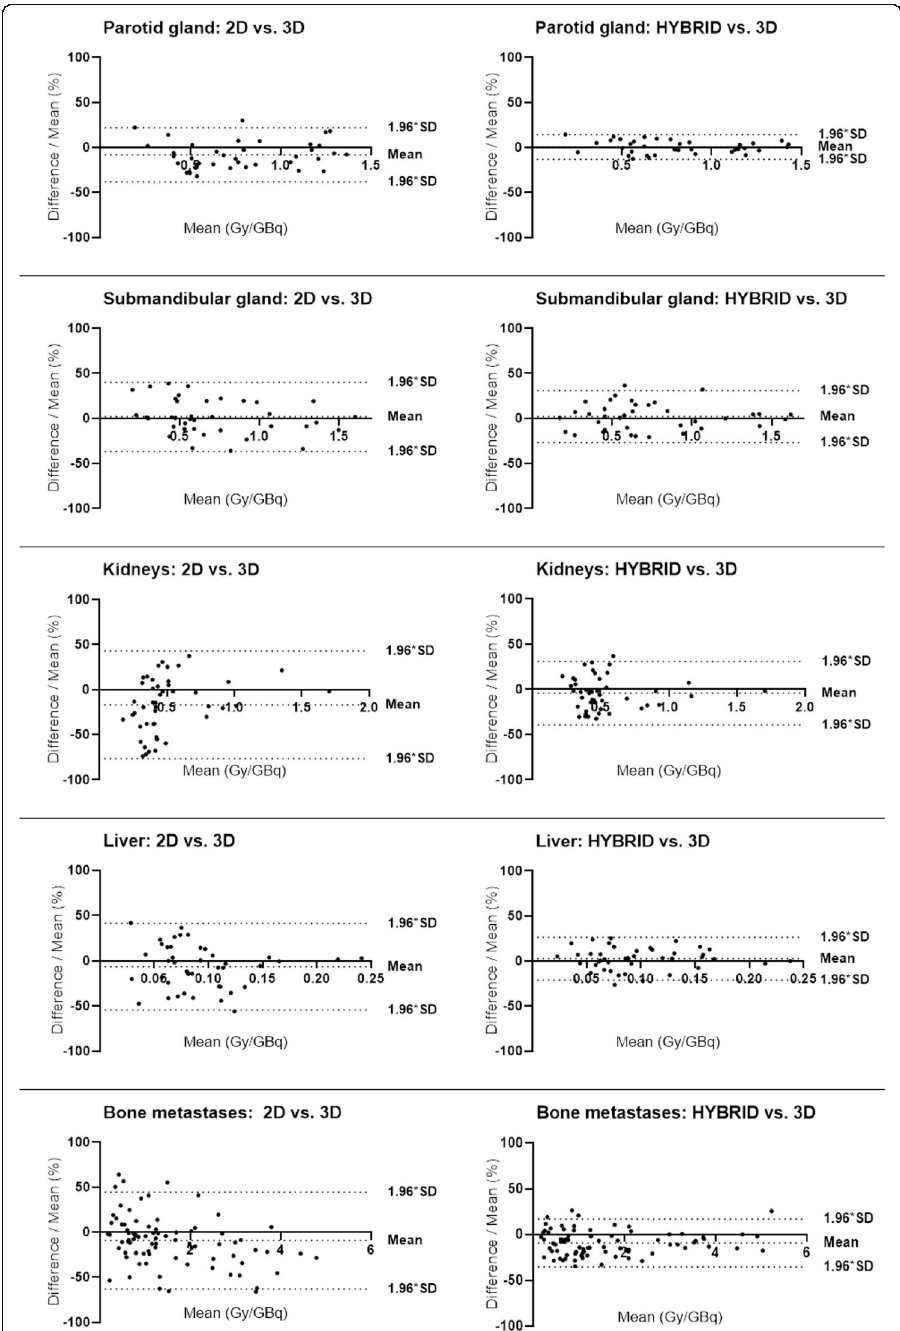
Fig. 2 Bland-Altman plots for parotid gland, submandibular gland, kidneys, liver, and bone metastases presenting pairwise quantification of the limits of agreement (dashed lines) of the relative absorbed dose difference for 2D dosimetry and hybrid dosimetry, respectively, compared to the results of 3D